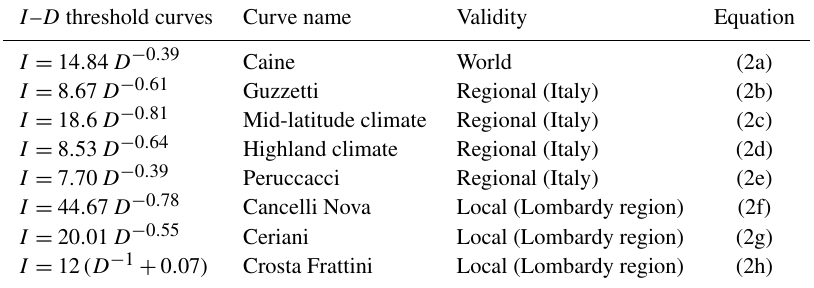
Table 2. I – D threshold curve set considered in this